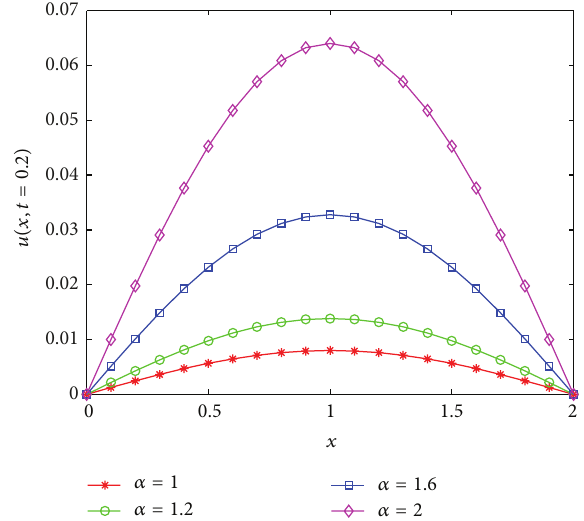
Figure 5: Dependence of the numerical solution for different values of 𝛼 by Numerical Algorithm II (see (61)) with 𝜏 = 0.0001, ℎ = 0.05 .